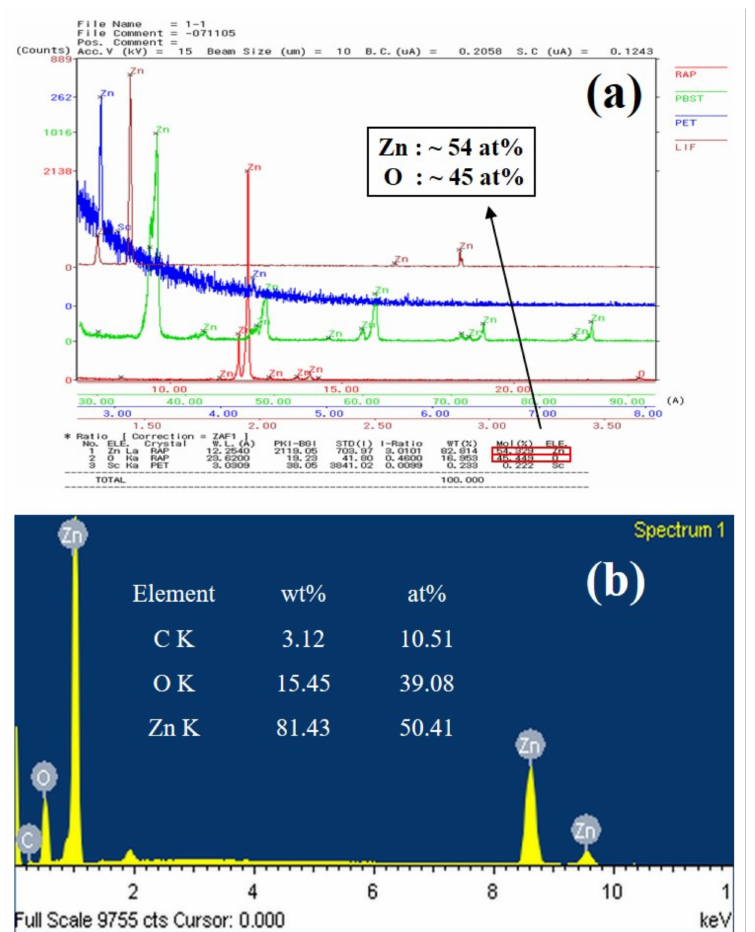
Figure 2. ( a ) EPMA and ( b ) EDS spectra of ZnO double-structured rods grown at a growth tempera- ture of 700 ◦ C for a growth time of 60